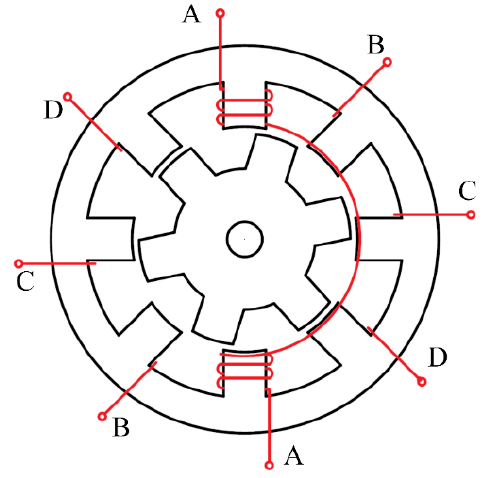
Figure 1. Cross-section of the four-phase 8/6 poles switched reluctance motor (SRM).